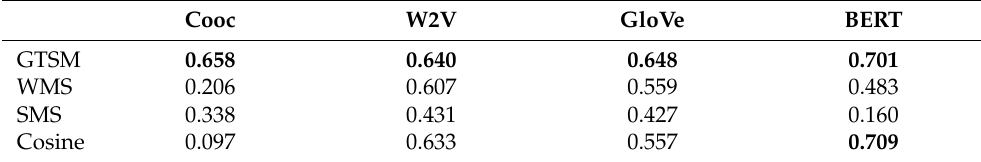
Table 2. Spearman correlation of metrics with human evaluations for different vector representations. Cooc W2V GloVe BERT GTSM 0.658